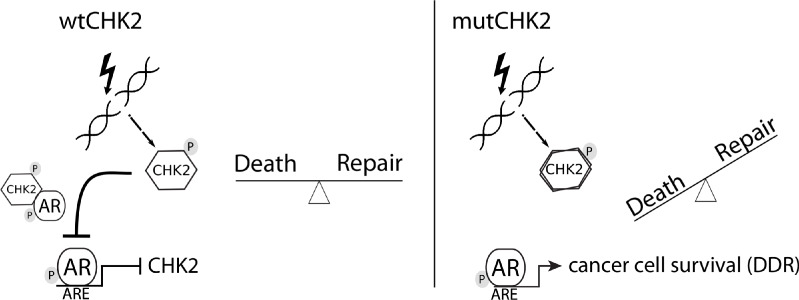
Model of CHK2-AR.We hypothesize the following model. In response to IR, CHK2 activation antagonizes AR through direct binding and inhibition of transcription of AR targets. CHK2 mutation or loss of expression that occurs in PCa leads to sustained AR transcriptional activity, an increase in DDR gene transcripts, and survival in response to DNA damage.